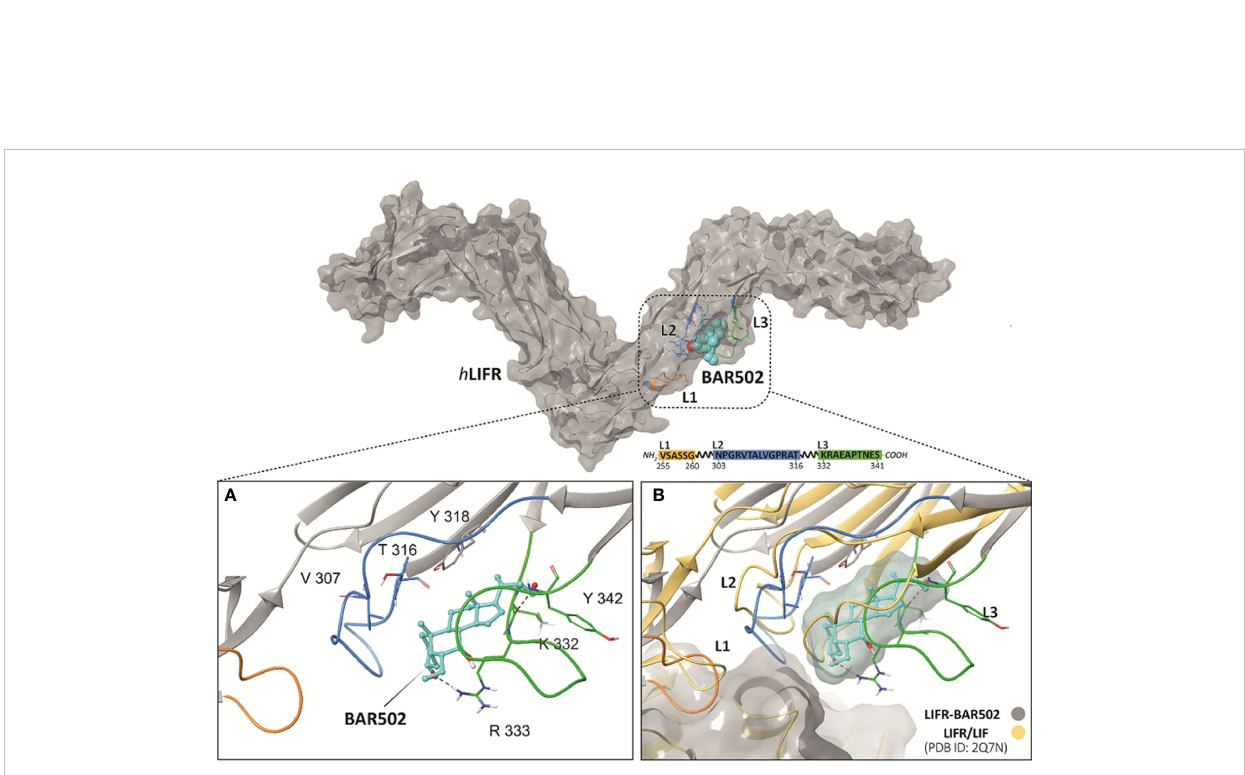
FIGURE 3 (A) View of the hLIFR-BAR502 representative cluster obtained after 100 ns of MD and (B) superimposed respect to the LIF-LIFR complex (PDB: 2Q7N). The pocket is de fi ned by three loops, namely L1 (255-VSASSG-260), L2 (303-NPGRVTALVGPRAT-316), and L3 (332-KRAEAPTNES-341) (rectangular), which was already characterized as binding sites for EC359 and Mifepristone. L1, L2 and L3 are highlighted in yellow, blue, and green, respectively. BAR502 (cyan) and the relevant residues are labelled and coloured.